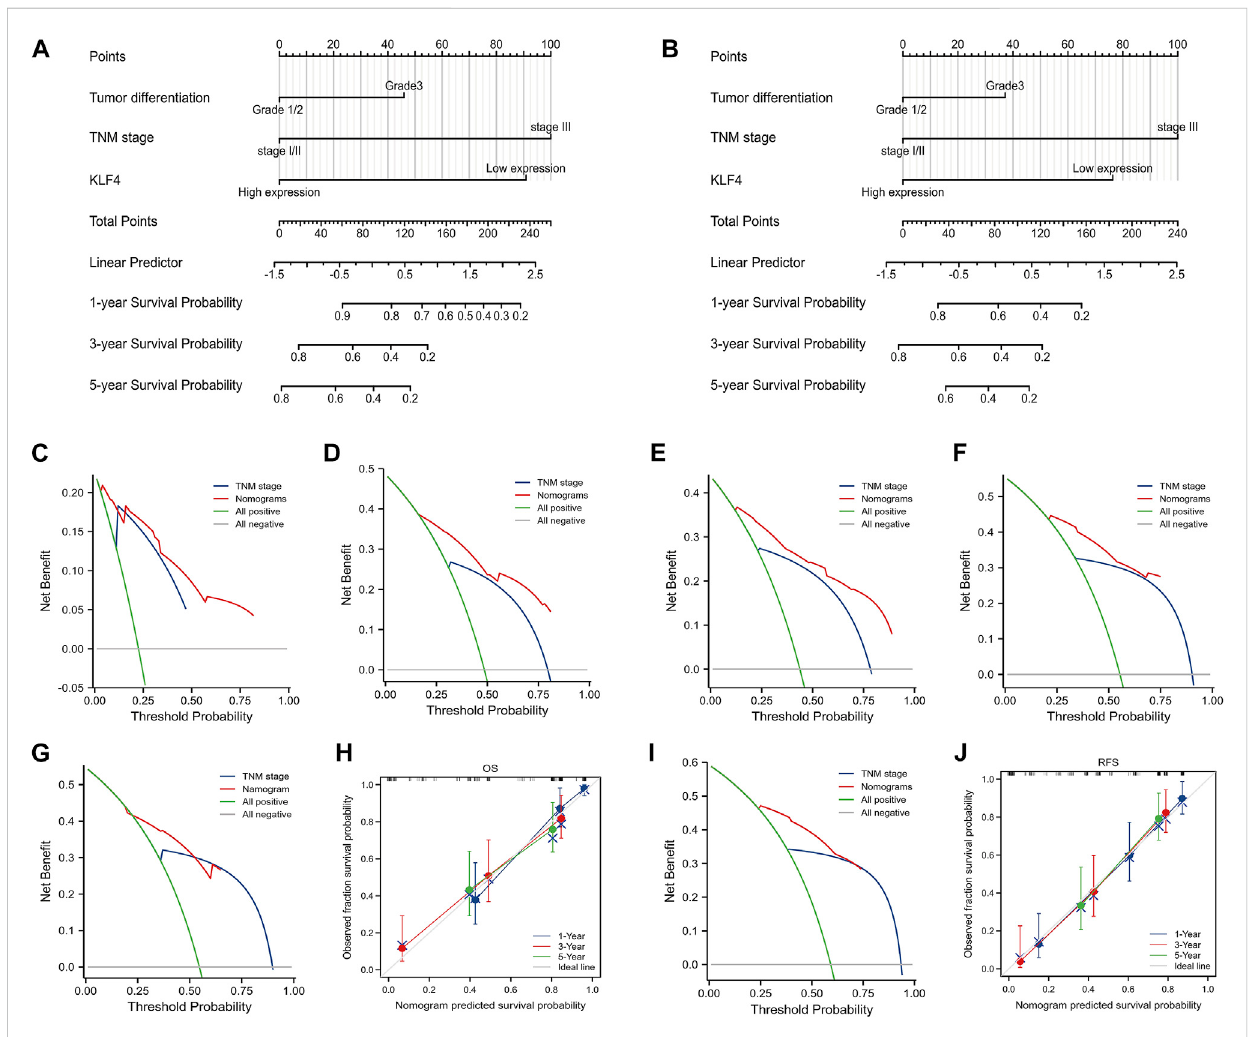
FIGURE 3 NomogramsandDCAbasedonKLF4expression.ThenomogrammodelswerecreatedbasedonexpressedKLF4andotherindependentprognostic factors (A) and (B) showed thepredictiveanalysis ofOS and RFSrespectively. The DCAcurvespresentedtheclinicalvalueofourmodels whencompared with TNM models (C) 1-year OS (D) 3-year OS (G) 5-year OS (E) 1-year RFS (F) 3-year RFS, and (I) 5-year RFS. Calibration plots compared predicted and actualsurvivalprobabilitiesat1-year,3-year,and5-yearOSandRFSwereshownin (H) and (J) ,respectively.Blueandredlines:theclinicalnetbene fi t atdifferentthresholdprobabilities;thesolidgrayhorizontalline:theassumptionthatnopatientssuffertheevent;thegreensolidline:theassumptionthat all patients suffer the